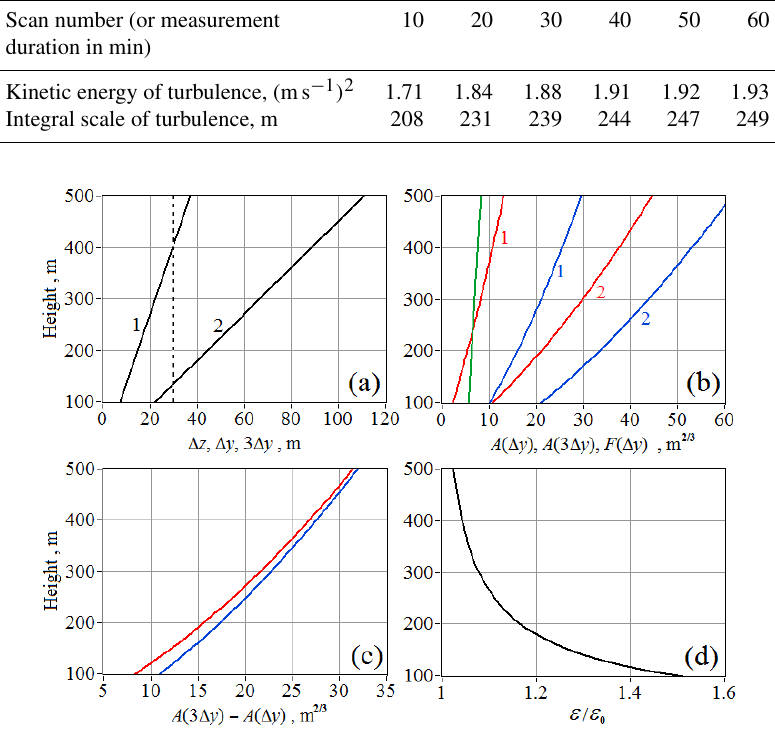
Figure 2. Vertical profiles of (a) longitudinal size of the sensing volume (cid:49)z (dashed line), transverse size of the sensing volume (cid:49)y k (curve 1) and 3 (cid:49)y k (curve 2); (b) F((cid:49)y k ) (green curve), A((cid:49)y k ) (red curve 1), A 0 ((cid:49)y k ) (blue curve 1), A (3 (cid:49)y k ) (red curve 2), and A 0 (3 (cid:49)y k ) (blue curve 2); (c) differences A (3 (cid:49)y k ) − A((cid:49)y k ) (red curve) and A 0 (3 (cid:49)y k ) − A 0 ((cid:49)y k ) (blue curve); (d) ratio ε/ε 0 .